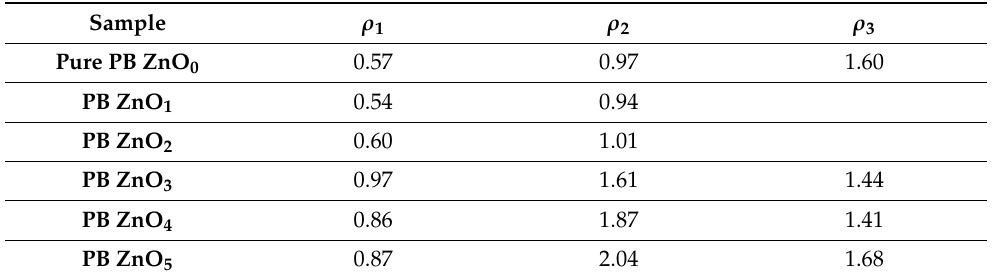
Table 6. The values of nonlinear exponent parameters for the ZnO doped in blend polymer.